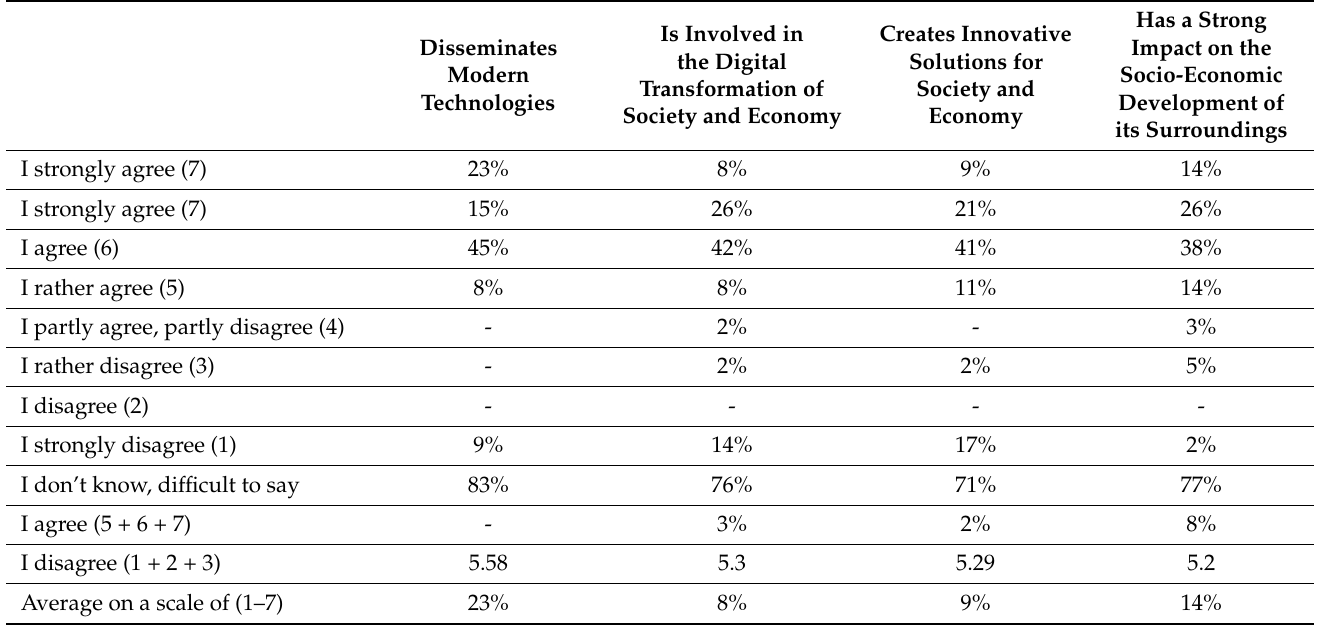
Table 5. Value exchange in the process of cooperation between HEIs and local economy actors.